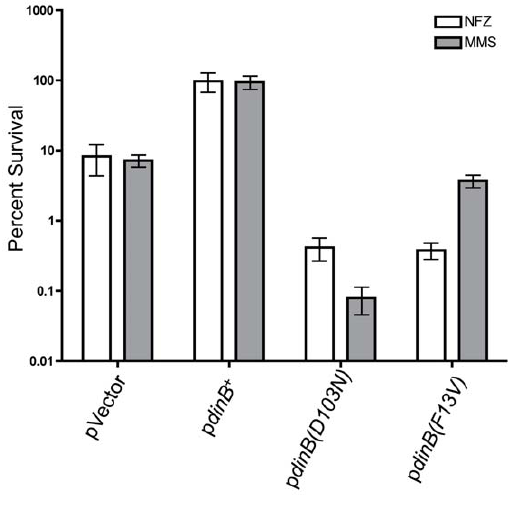
Figure 2. D dinB is rescued from MMS and NFZ lethality only by dinB + . ( A ) Neither plasmid-borne DinB(D103N) nor DinB(F13V) rescue D dinB cells treated with MMS (7.5 mM) or NFZ (0.008 mM). Enhanced sensitivity to MMS is observed in D dinB with DinB(D103N) (gray bars). D dinB strains with either DinB(F13V) or DinB(D103N) variants exhibit an enhanced cellular sensitivity to NFZ compared to D dinB (pVector, white bars) as previously reported [16]. Error bars represent the standard deviation of the mean from at least 3 independent experiments.